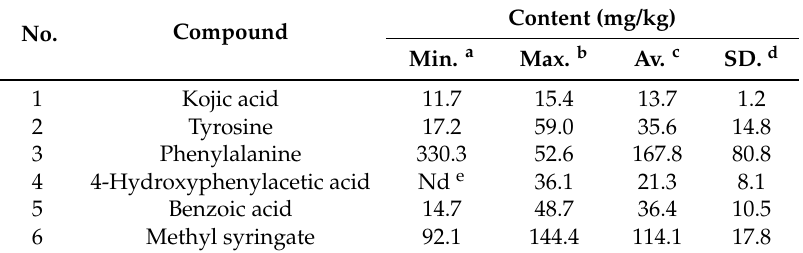
Table 1. The compounds identified by targeted HPLC-DAD analysis of the native honey samples. Content (mg/kg) No. Compound Min. a Max. b Av. c SD. d 1 Kojic acid 11.7 15.4 13.7 1.2 2 Tyrosine 17.2 59.0 35.6 14.8 3 Phenylalanine 330.3 52.6 167.8 80.8 4 4-Hydroxyphenylacetic acid Nd e 36.1 21.3 8.1 5 Benzoic acid 14.7 48.7 36.4 10.5 6 Methyl syringate 92.1 144.4 114.1